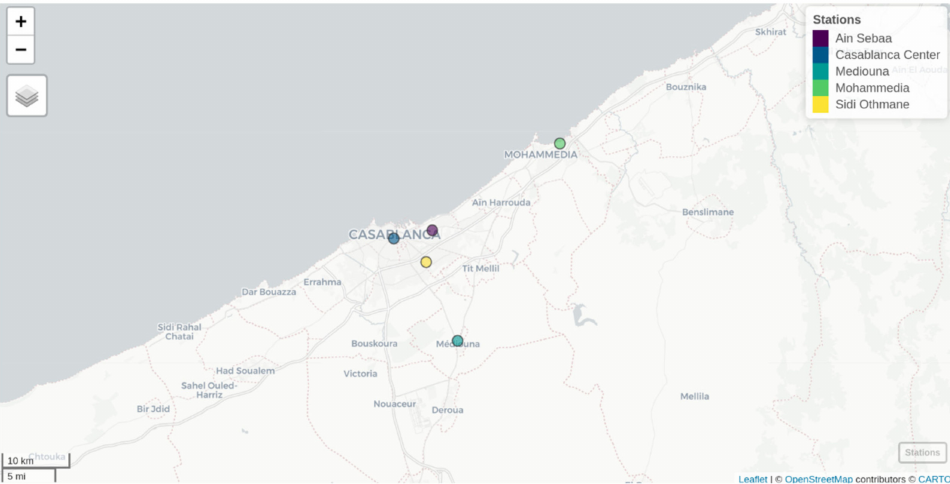
Figure 1. Location map of the meteorological stations included in this